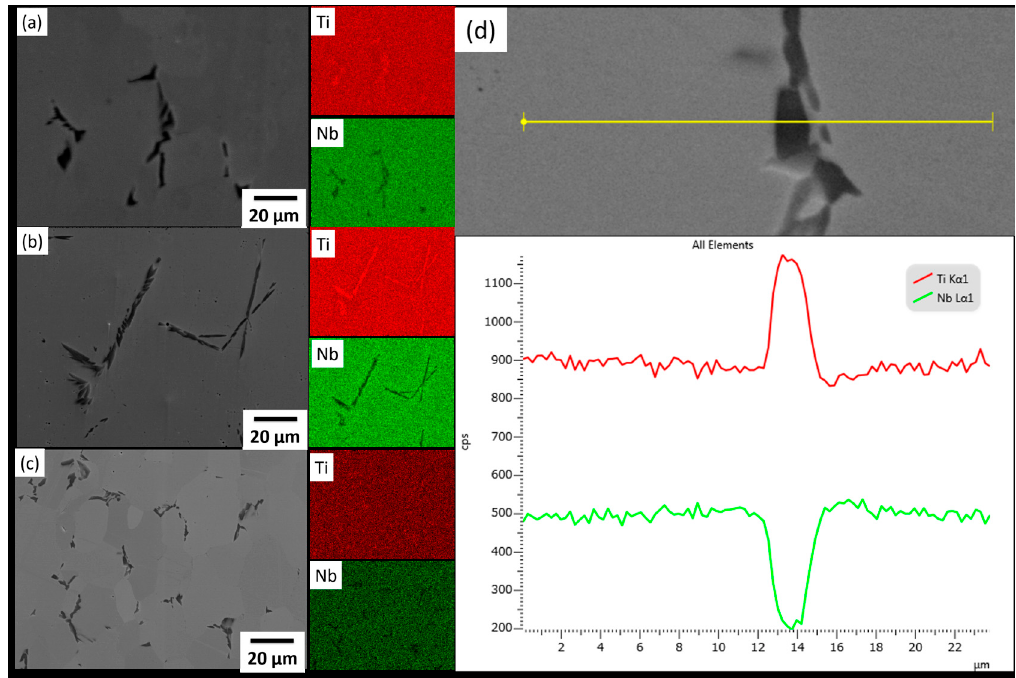
Figure 6. Typical SEM micrographs of ( a ) Ti-154; ( b ) Ti-244; ( c ) Ti-334 specimens with their Energy-dispersive X-ray spectroscopy (EDS) elemental mappings; and ( d ) line analysis of Ti-334 specimen.